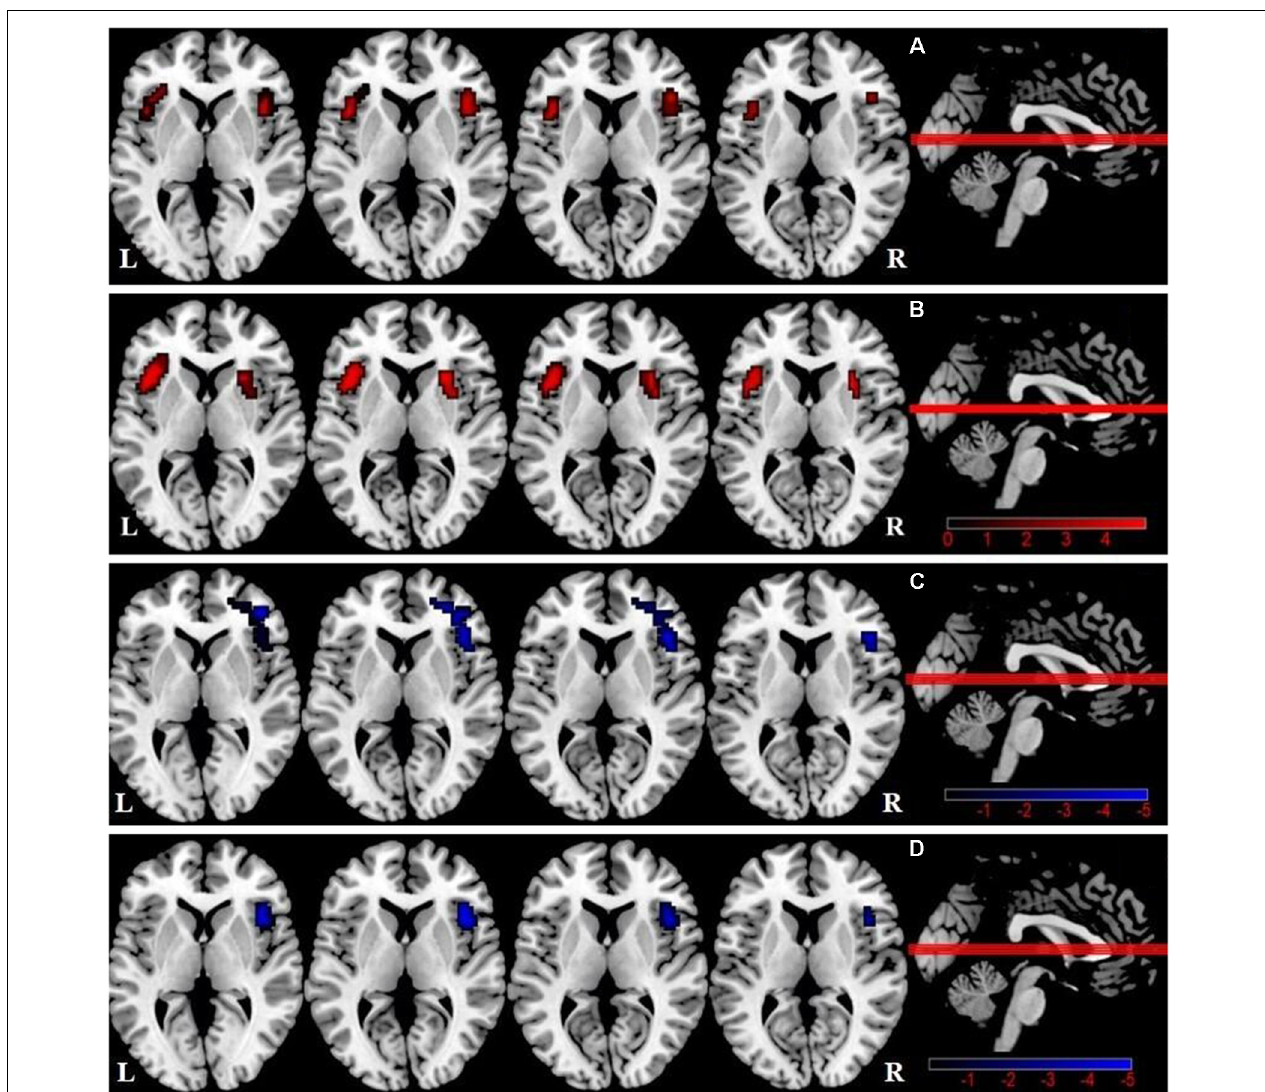
FIGURE 1 | Differences in intra-salience network (SN) functional connectivity (FC; P < 0.05, GRF-corrected) among the three groups. (A) A one-way analysis of variance (ANOVA) showed brain regions with differences in FC among the three groups. (B) Differences in intra-SN FC between DMCN patients and healthy controls (HCs). (C) Differences in intra-SN FC between DMCI patients and HCs. (D) Differences in intra-SN FC between DMCI patients and DMCN